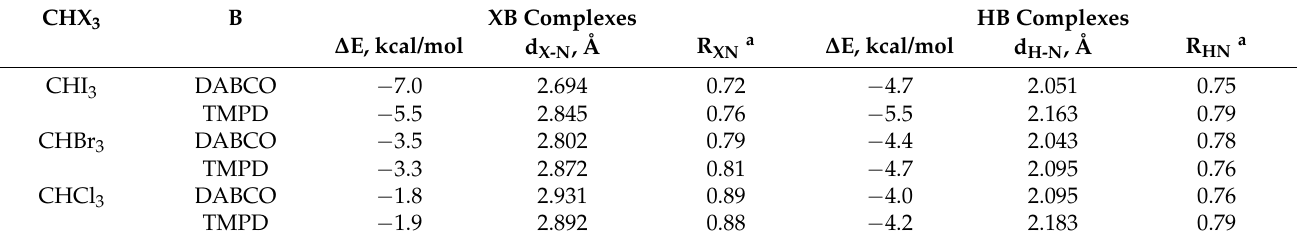
Table 1. Interaction energies and interatomic distances in the XB and HB complexes.